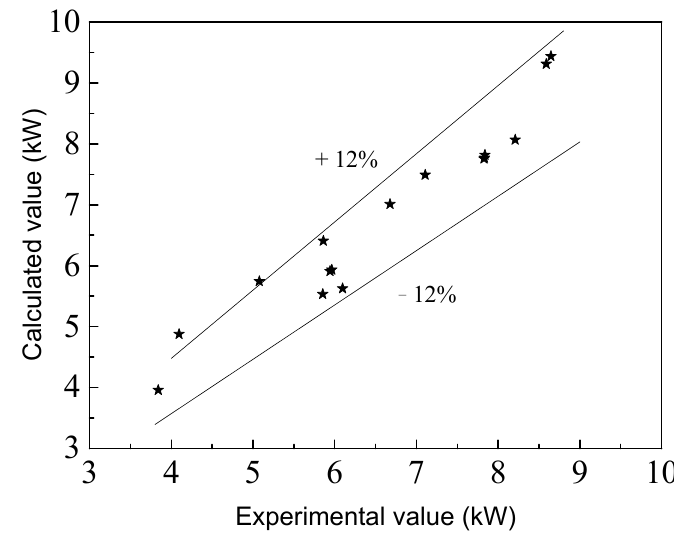
Figure 11. Relative error between calculated value and experimental value.